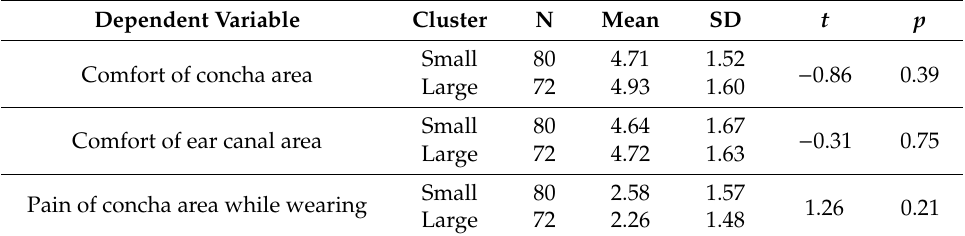
Table 12. Results of independent sample t -test for wearing comfort di ff erence according to ear canal–incisura intertragica length